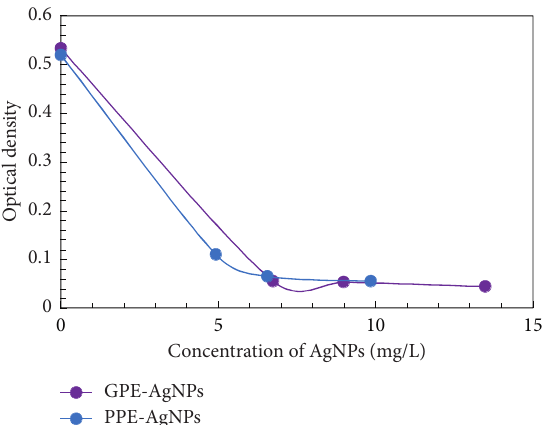
Figure 12: Optical density of test tubes with E. coli culture and different concentrations of AgNP grape pomaces and pomegranate peel extracts after 24 hours of cultivation. Table 9: A summary of plant-based extracts as Ag reducing agent.